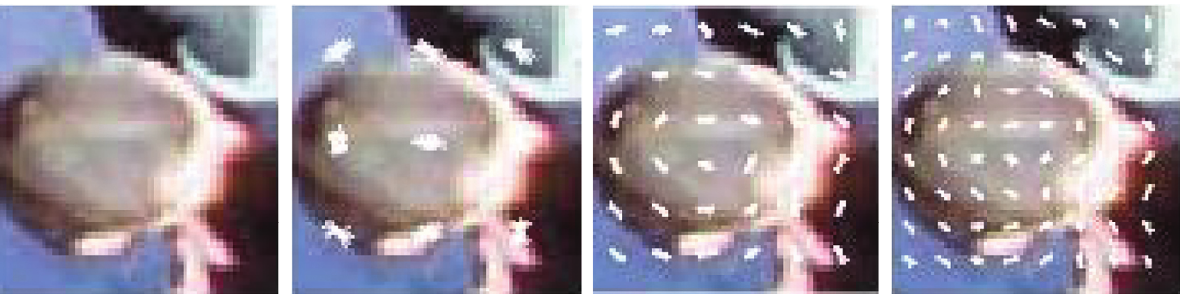
Figure 8: From left to right: the original object image [51, 51] px and images with highlighted gradients of HOG features for cell of sizes [16, 16] px, [8, 8] px, and [6, 6] px, respectively. The length of white abscissae is related to the gradients in the